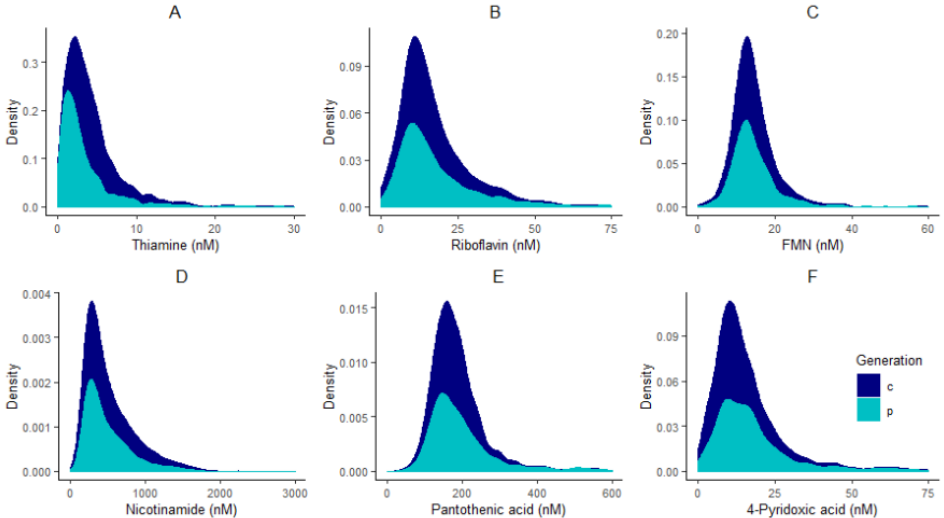
Figure 1. Distribution plots of thiamine ( A ), riboflavin ( B ), FMN ( C ), nicotinamide ( D ),